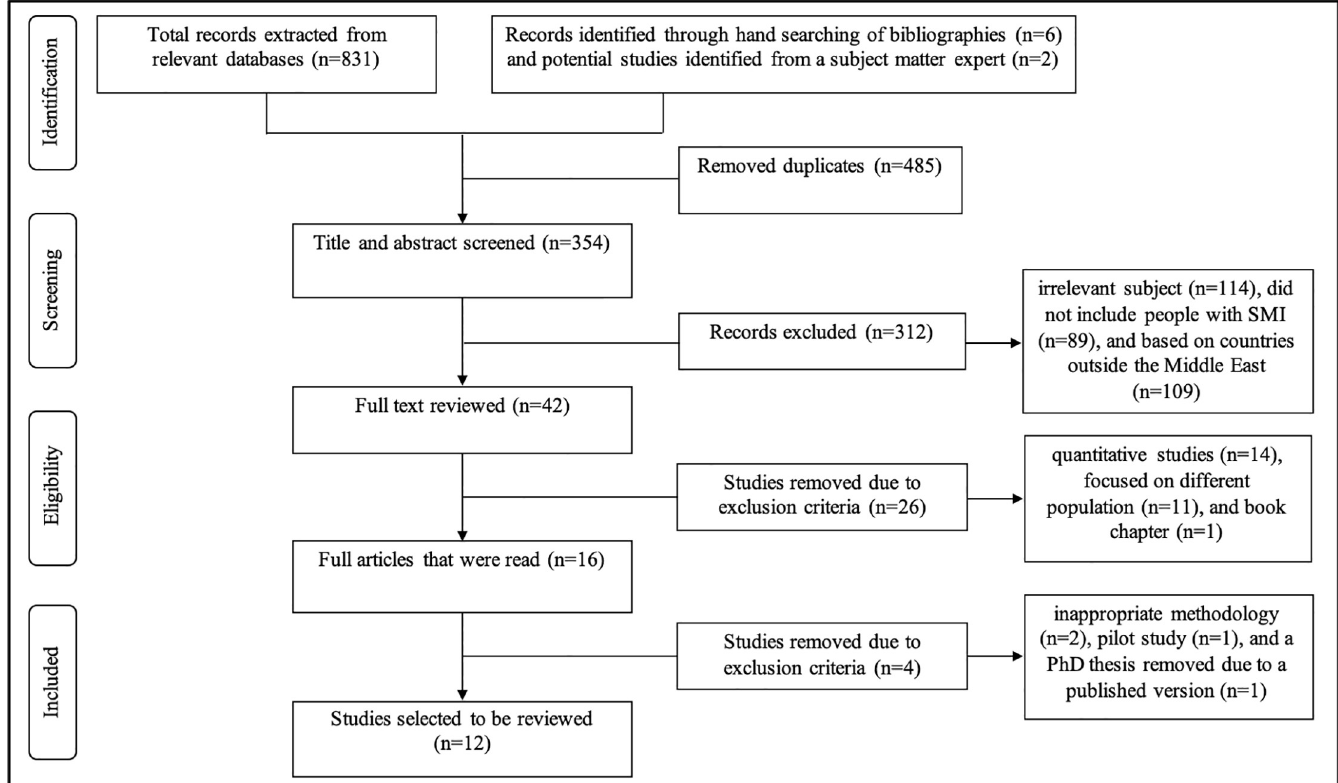
Fig 1. PRISMA flowchart-study selection